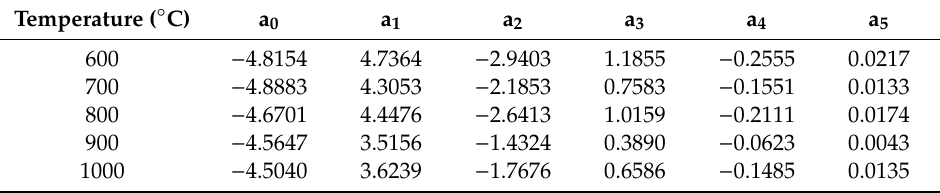
Figure 13. Calibration curves at high temperatures. Table 4. Calibration fitting curve parameters at different temperature.